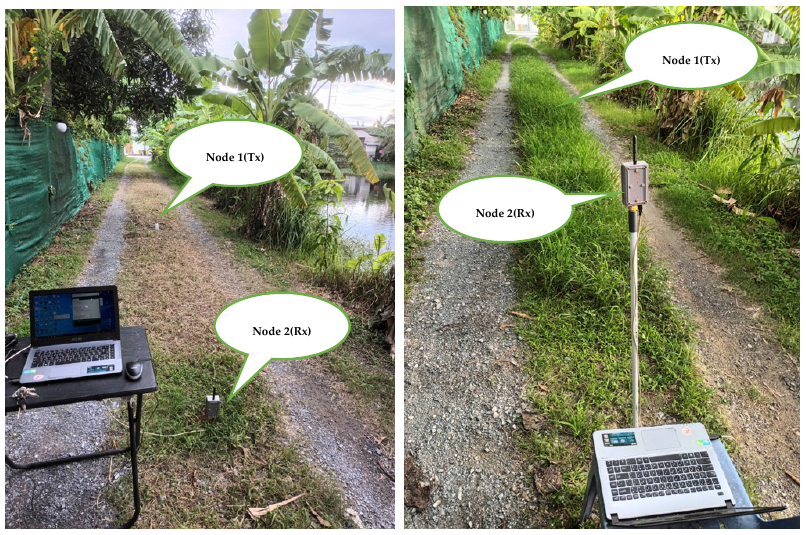
Figure 3. RSSI measurement for short grass ( left ) and tall grass ( right ).